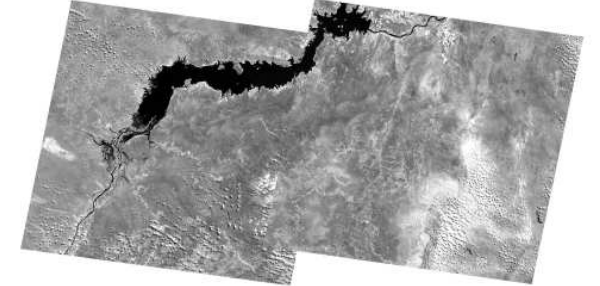
Figure 2: Mosaic of June 2011.